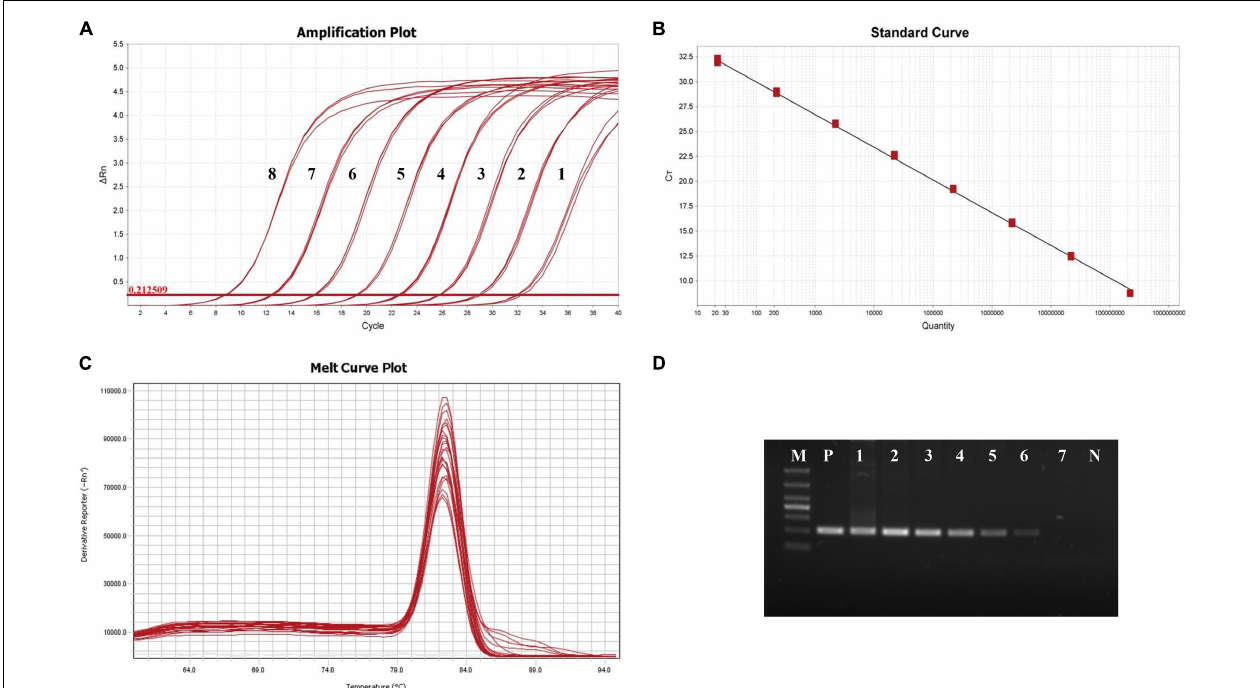
FIGURE 2 | Amplification of the standard samples. (A) The amplification curve of RPS9-qPCR. 1: 2.2 × 10 1 copies/ µ L; 2: 2.2 × 10 2 copies/ µ L; 3: 2.2 × 10 3 copies/ µ L; 4: 2.2 × 10 4 copies/ µ L; 5: 2.2 × 10 5 copies/ µ L; 6: 2.2 × 10 6 copies/ µ L; 7: 2.2 × 10 7 copies/ µ L; and 8: 2.2 × 10 8 copies/ µ L. (B) Standard curve of qPCR-RPS9. (C) Melting curve of qPCR-RPS9. (D) Agarose electrophoresis of conventional PCR-RPS9. M: DL1000; P: EAM; N: Hepatopancreas DNA of healthy shrimp; 1: 2.2 × 10 7 copies/ µ L; 2: 2.2 × 10 6 copies/ µ L; 3: 2.2 × 10 5 copies/ µ L; 4: 2.2 × 10 4 copies/ µ L; 5: 2.2 × 10 3 copies/ µ L; 6: 2.2 × 10 2 copies/ µ L; and 7: 2.2 × 10 1 copies/ µ